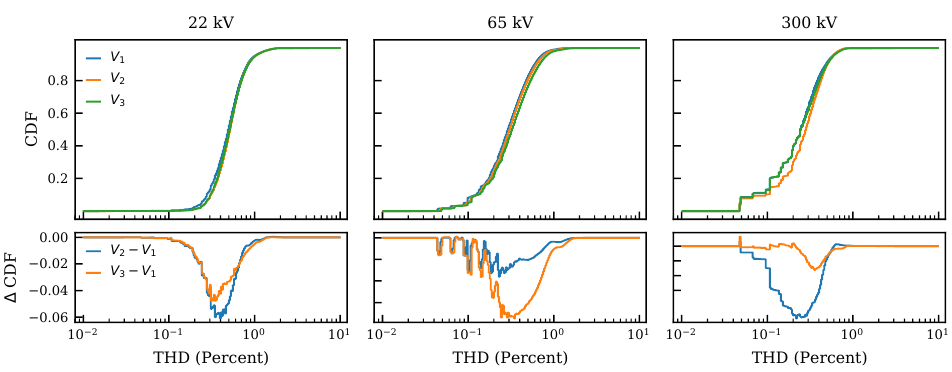
Figure 4. Variation in t he occurrence of non-zero values for each node averaged on a daily basis. The 3rd, 5th and 7th harmonics have been selected.